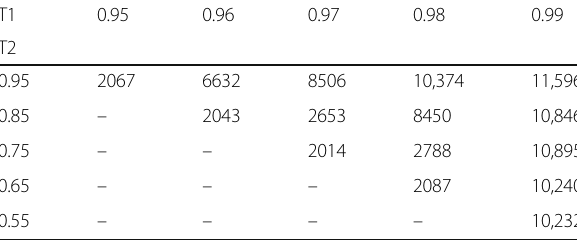
Table 2 Calculation of different T1 and T2